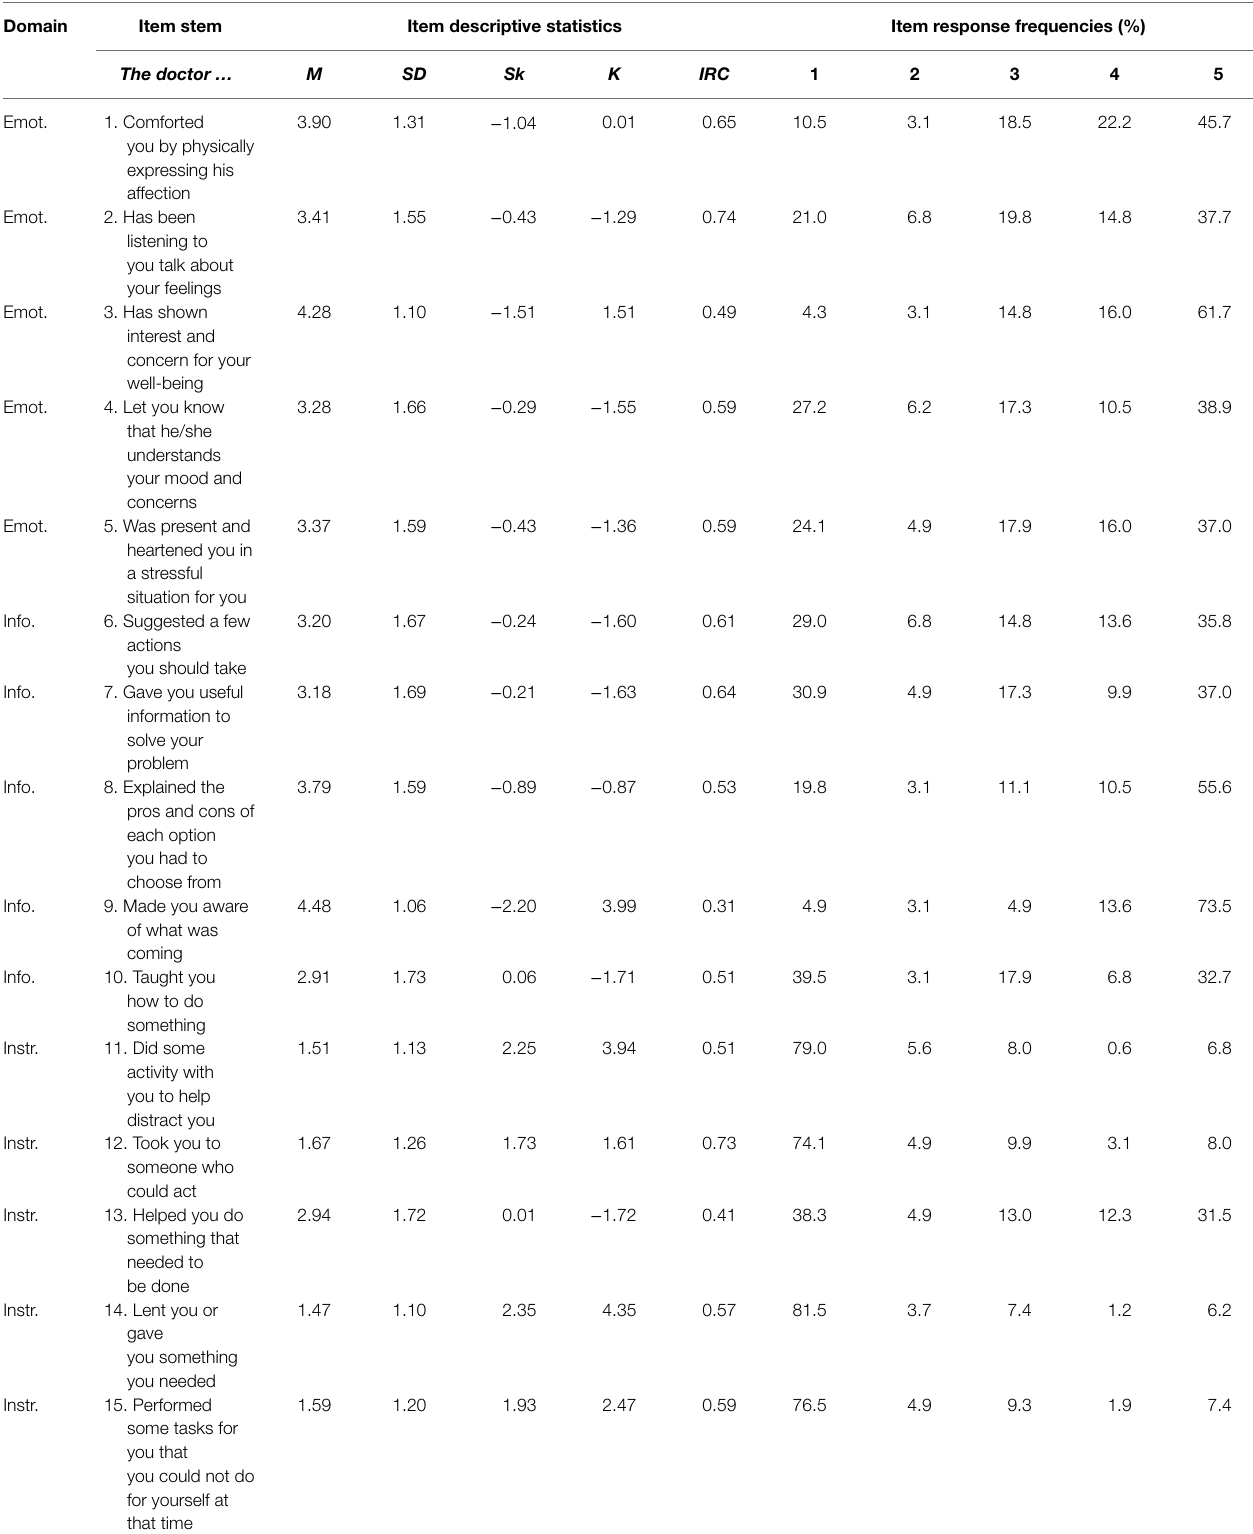
TABLE 2 | Descriptive statistics and response frequencies for the Healthcare Perceived Social Support items. Domain Item stem Item descriptive statistics Item response frequencies